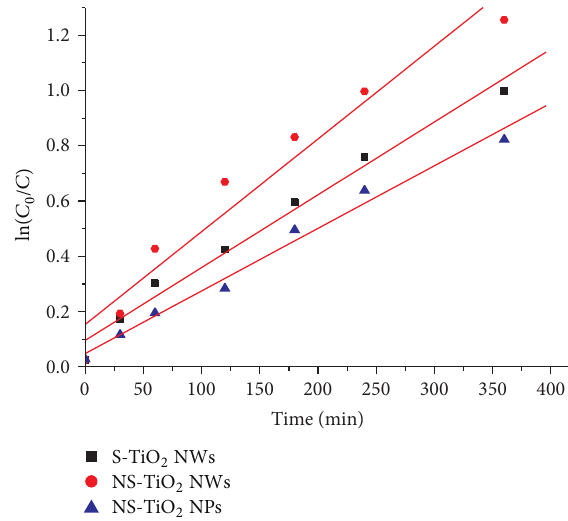
Figure 7: Kinetics of photocatalysts for the degradation of atrazine. Table 1: Apparent first-order rate constants and TOC removal obtained from atrazine degradation by doped TiO